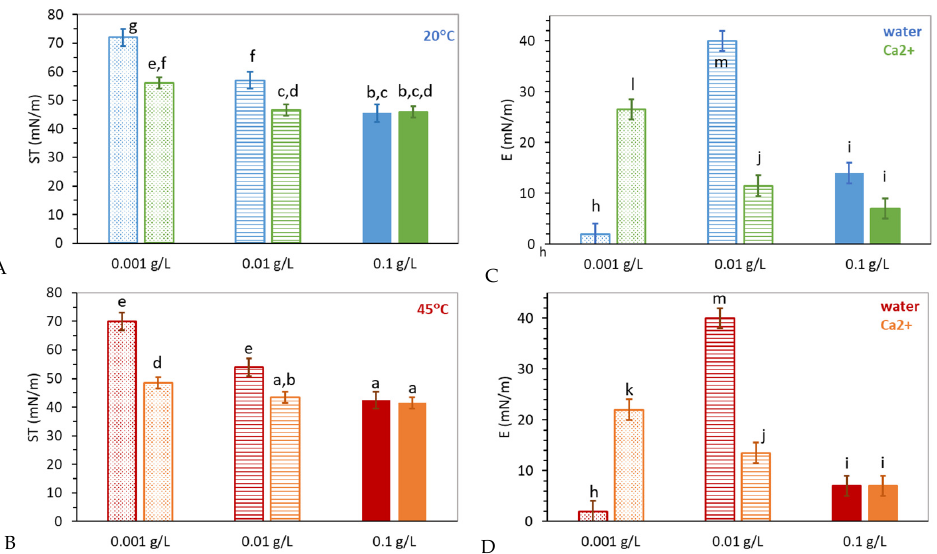
Figure 8. ( A , B ) Final surface tension, measured after different time scales from Figure 7, and ( C , D ) dilatational elastic modulus (0.1 Hz) reached after adsorption at constant surface area for different mGel − concentration, temperature, and subphase: 0.1 g L − 1 (solid bar), 0.01 g L − 1 (striped bar), 0.001 g L − 1 (dotted bar). ( A,C ) Swollen microgels, 20 °C in water (blue), in 1 mM Ca(NO 3 ) 2 (green). ( B , C ) Shrunken microgels, 45 °C in water (red), in 1 mM Ca(NO 3 ) 2 (orange). Plotted values are the mean of at least three experiments and the error bars stand for standard deviation. The statistics study was conducted considering the mean value, deviations, and number of repetitions of each experiment and comparing the final surface tension (a–g) and the dilatational elastic modulus (h–m), independently. Different letters (a–g) and (h–m) indicate significant differences between samples ( p < 0.05).